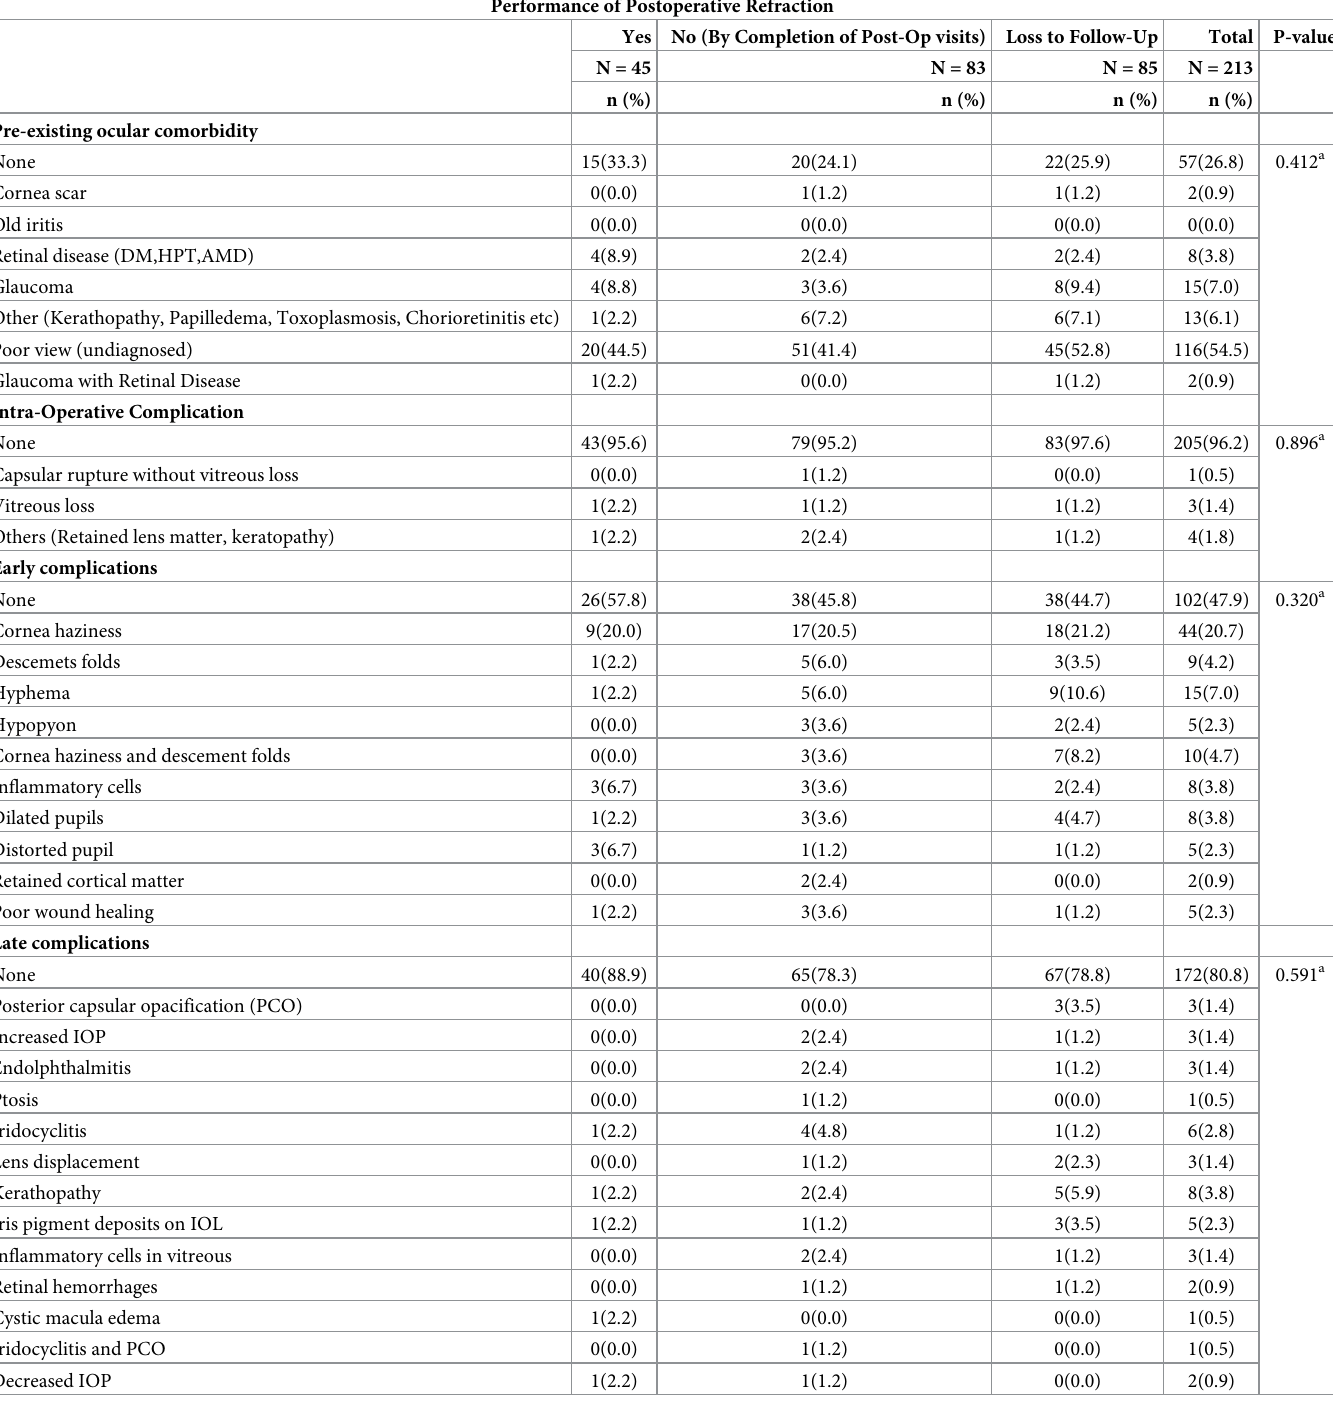
Performance of Postoperative